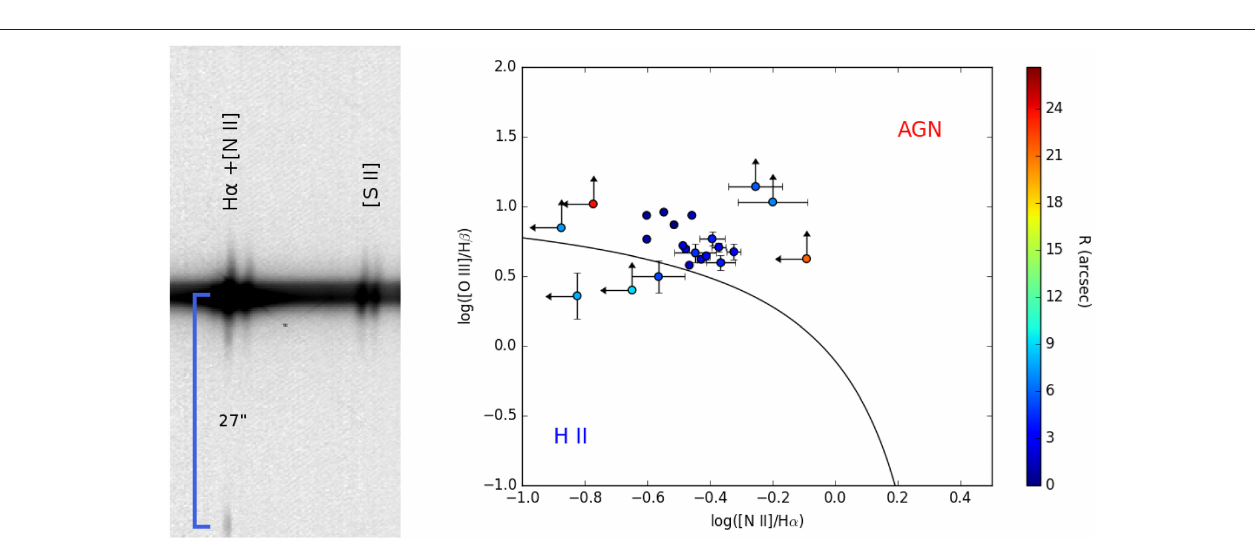
FIGURE 2 | Left: H α region of the same spectrum in Figure 1B . Right: Preliminary diagnostic diagram of the ENLR of Mrk 783. The colorbar show the distance of the bin from the nucleus. The black line dividing the plot in two regions is the relation from Kewley et al. (2006) for extreme starburst. The arrows show the limit derived where we could not measure all the emission